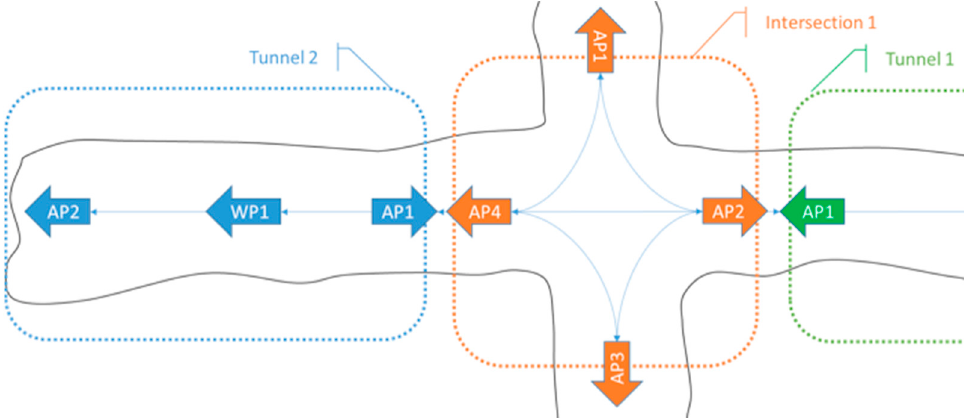
Figure 5. TM example showing one intersection node (Intersection 1), two tunnel nodes (Tunnel 1 and Tunnel 2), and the corresponding APs, WPs and connections between them.